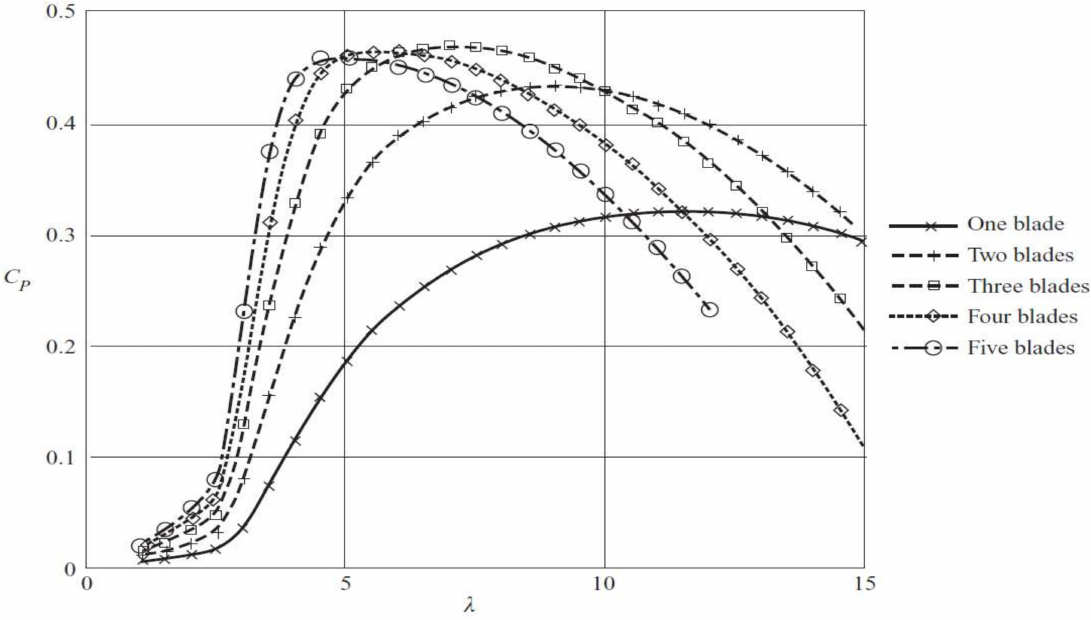
Figure 18. The power coefficient as a function of the tip speed ratio ( λ ) and the number of blades